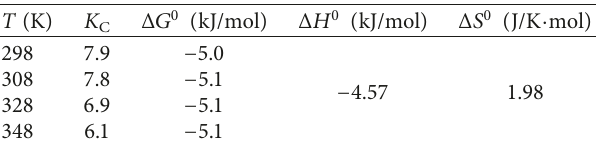
Figure 5: Effect of the temperature on cobalt adsorption using 20mg/L, particle size MCSG60A. Conditions: [Co 2+ ] (cid:30) pH 6, adsorbent dosage 12.5g/L, and 1100rpm. (cid:30) (cid:30) Table 2: Thermodynamic analysis of the cobalt adsorption on MCSG60A.